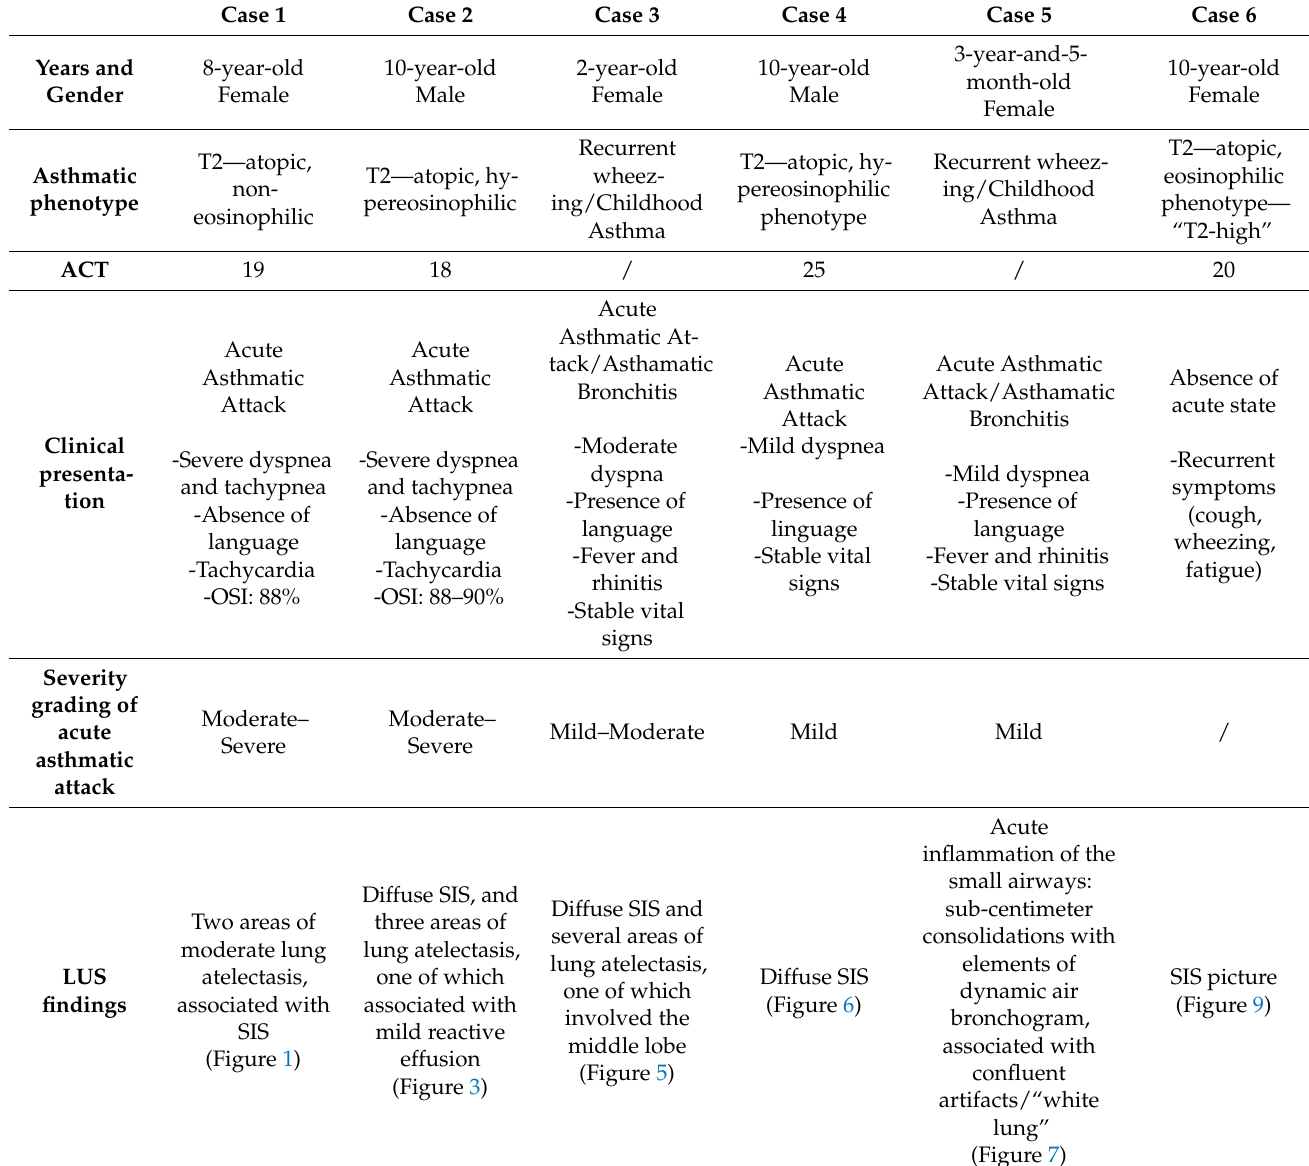
Table 1. Clinical results and lung ultrasound findings of case